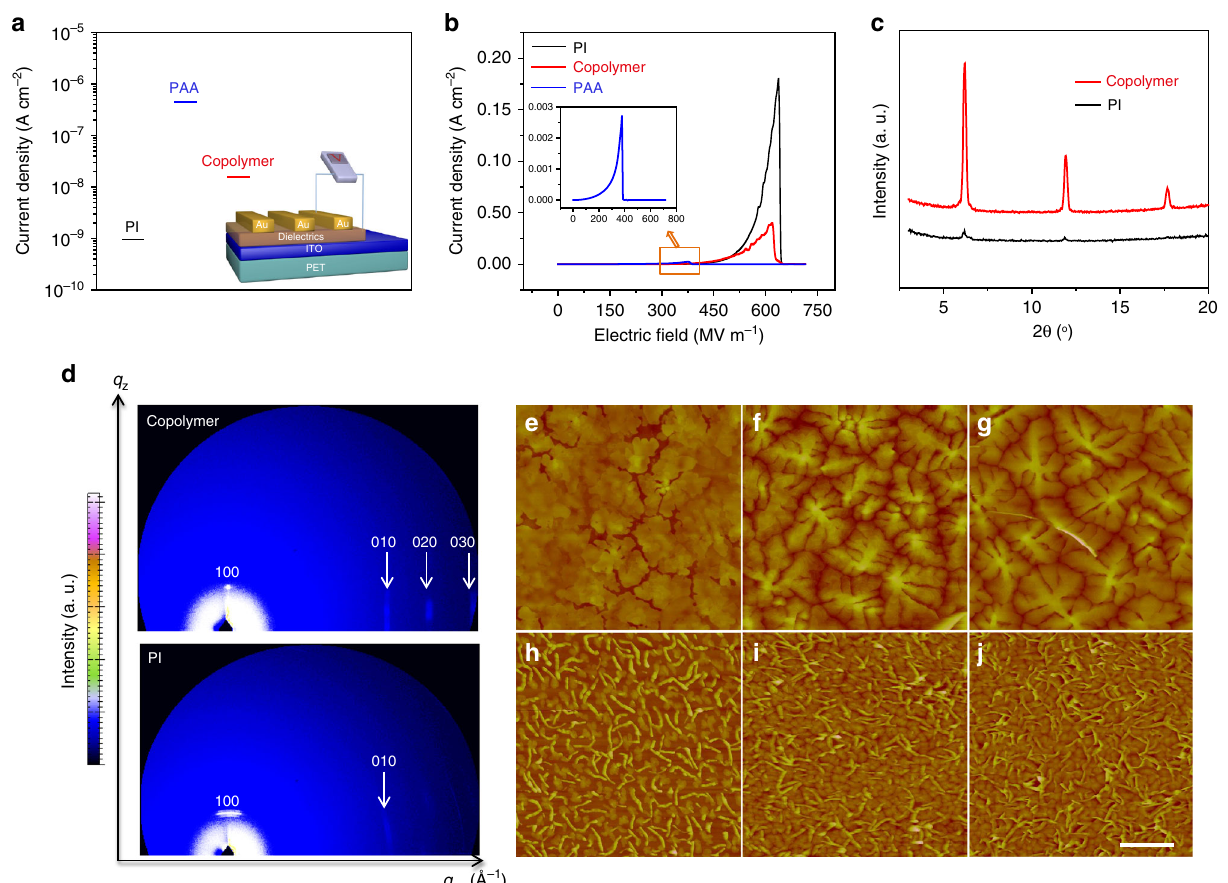
Fig. 3 The characterizations of dielectric properties and the growth mode of pentacene on the surface of dielectrics. a Current density of the dielectric layers at the bias voltage of 5 V. Inset, an Au/dielectrics (160 nm)/ITO sandwiched device structure for tests. b Current density as a function of electric fi eld. c XRD patterns of pentacene fi lms (50 nm) grown on copolymer and PI surfaces. d 2D GIXRD patterns of pentacene fi lms (50 nm) on the surface of copolymer and PI. AFM images of pentacene fi lms grown on dielectric substrates with different thicknesses (4.5, 15, and 50 nm). e – g on copolymer surface; h – j on PI surface. Scale bar, 1 µ